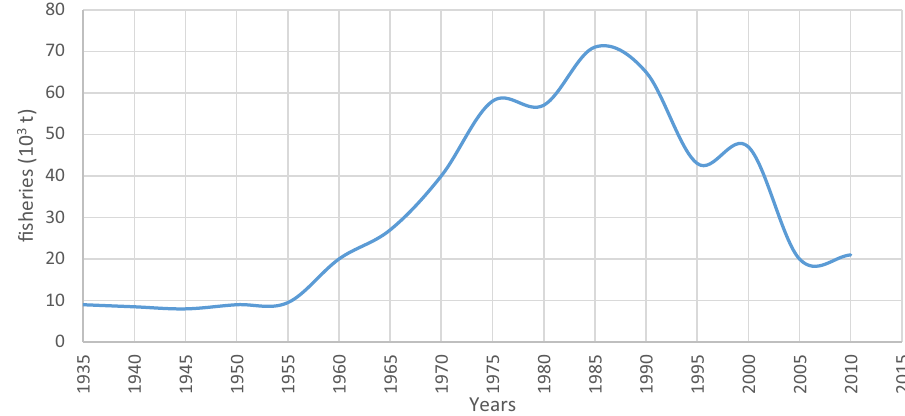
Fig. 2 Total Cuban catches within the Exclusive Economic Zone from 1935 to 2010